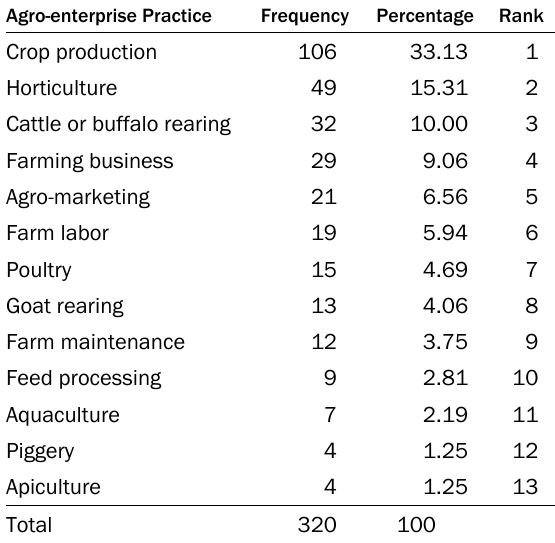
Table 4. Level of Youth Involvement in Agro-